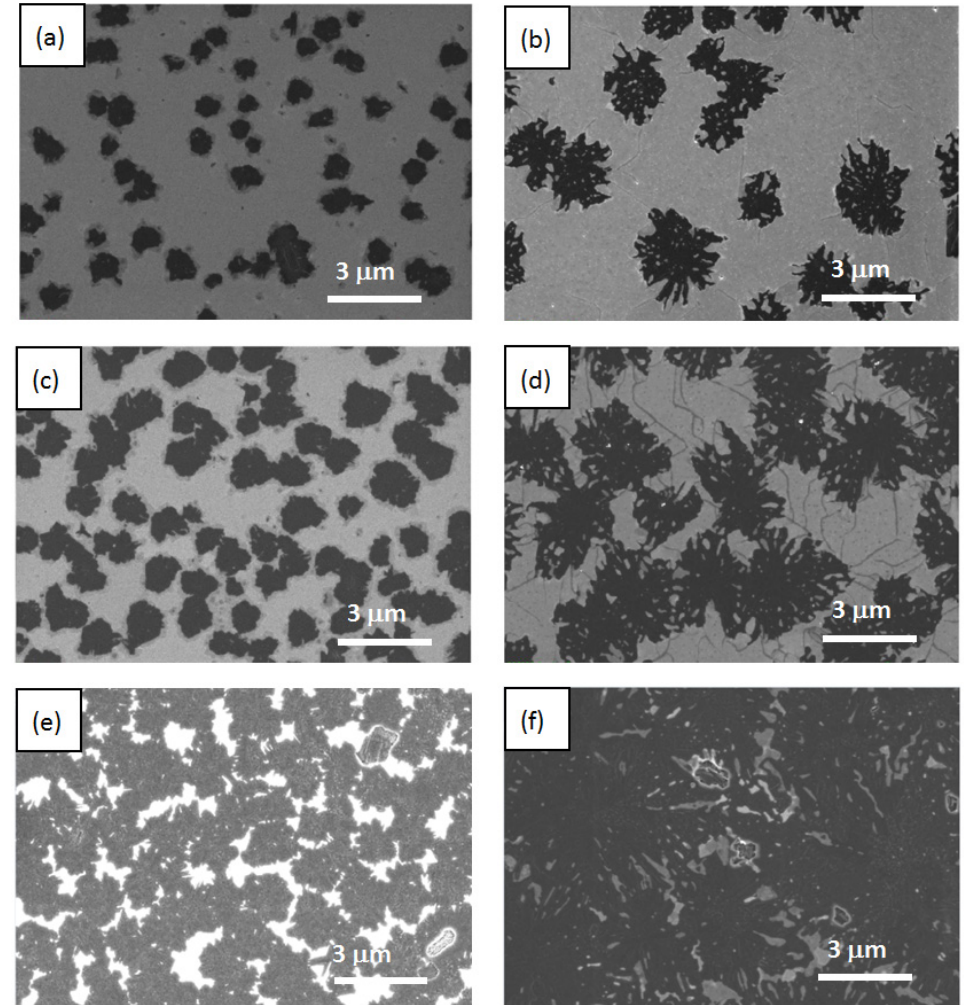
Figure 2. SEM data obtained for structures with different thicknesses. Left column—29 nm thick film; right column—53 nm thick film. Panels ( a , b ) correspond to a 2 min exposure time. Panels ( c , d ) correspond to a 4 min exposure time. Panels ( e , f ) correspond to a 10 min exposure